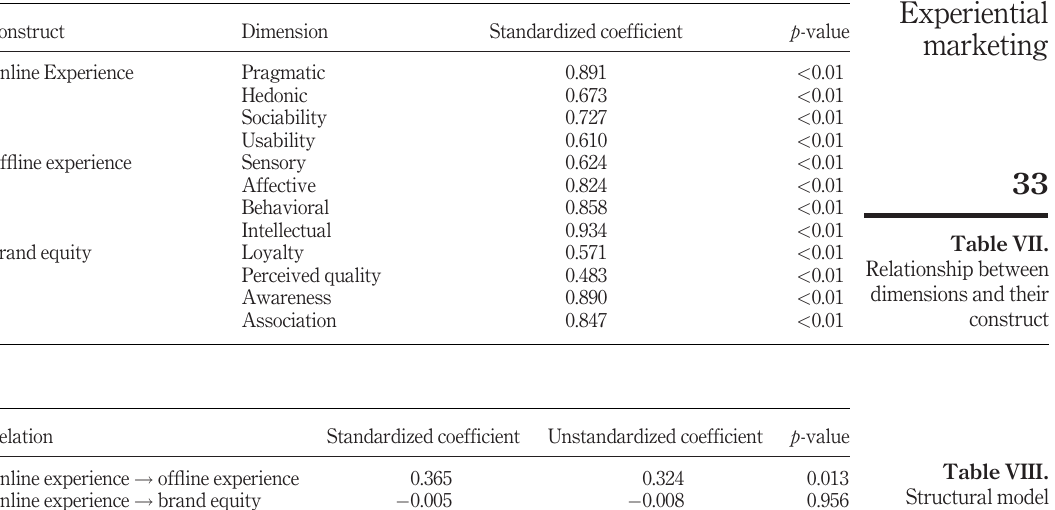
Table VIII. Structural model